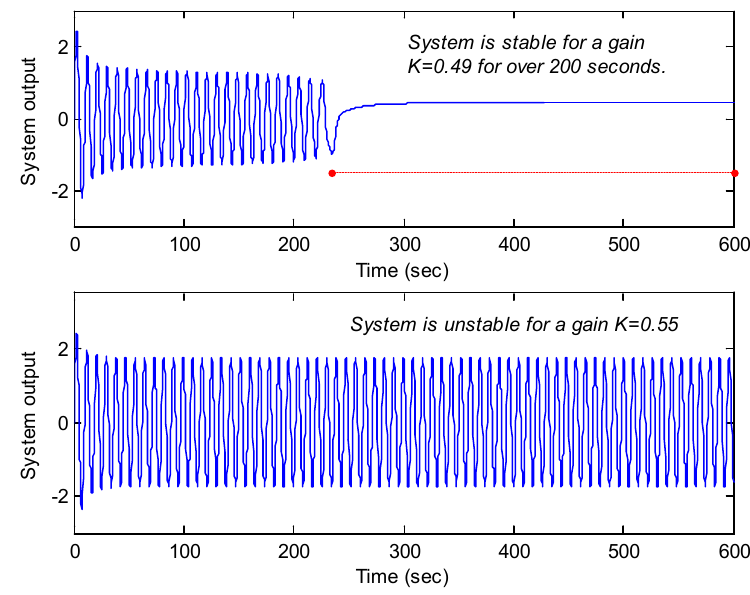
Figure 23. Time responses of closed loop system in Figure 19 with Equation (43) and relay with dead zone for K = 0.49 and